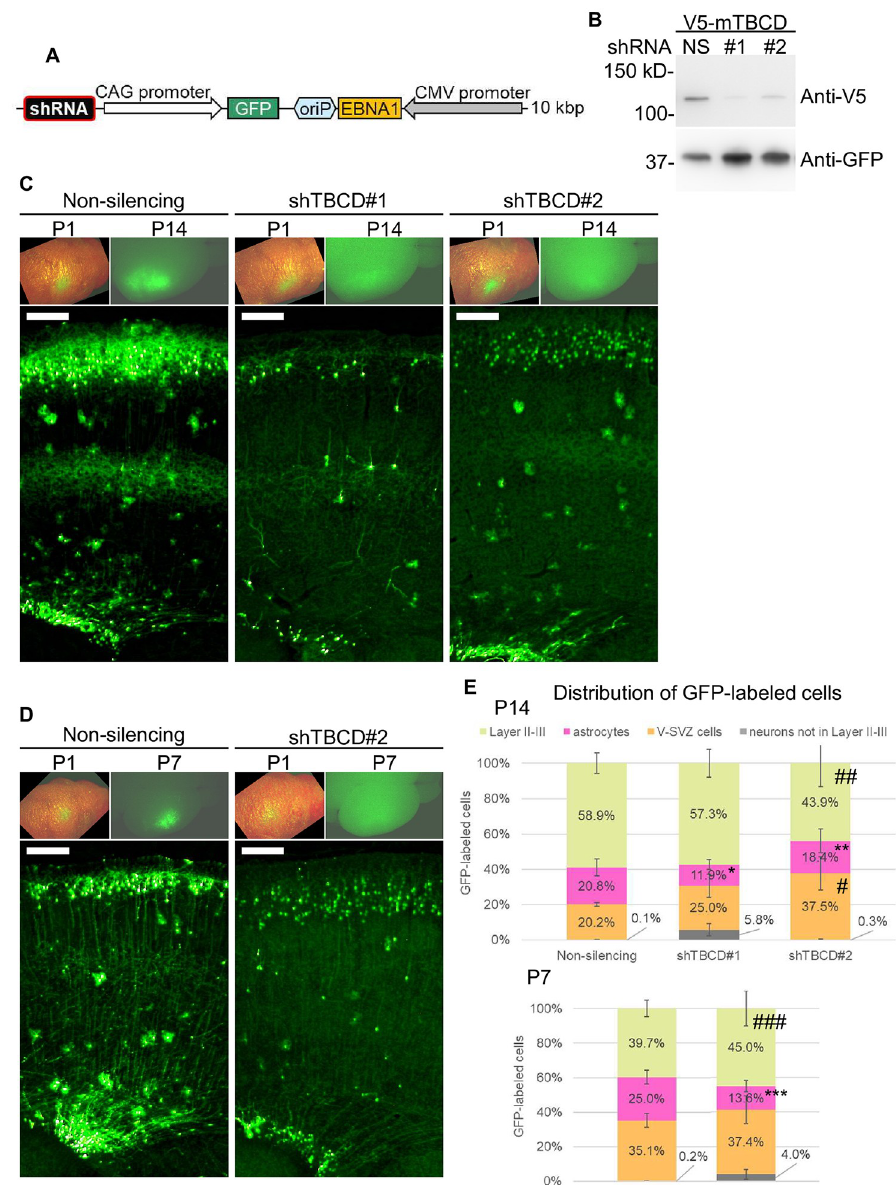
Fig 7. IUE of the EB-oriP plasmid encoding shRNA against TBCD suggests the role of TBCD in postnatal cerebral cortex. (A) Schematic illustration of the EB-oriP plasmid encoding shRNA expression in addition to GFP expression. The expression cassette of shRNA targeting mouse TBCD or non-silencing control was cloned into pCAG-GFP-EB-oriP plasmid (Fig 1A). IUE of these plasmids was performed at E15 and the brains were analyzed at P7 and P14. (B) Lysates prepared from HEK293T cells co-transfected with plasmids for V5-tagged mouse TBCD and plasmid shown in (A) (NS, non-silencing; #1 and #2, two independent shRNAs against TBCD) were analyzed by western blot with the indicated antibodies. (C and D) Representative GFP fluorescence of the head of a mouse transfected with the indicated plasmid at P1 was merged with the bright-field image (upper left). GFP fluorescence of the brain shown in left panel at P14 (C, upper right) and P7 (D, upper right). Representative GFP fluorescence of coronal section from the brain is shown in upper right panel. (E) Quantification of the distribution of GFP-labeled cells at P14 (upper) and P7 (lower) (P14: NS, n = 4085, from four mice; shTBCD#1, n = 926, from three mice; shTBCD#2, n = 1873, from four mice, P7: NS, n = 2768, from four mice; shTBCD#2, n = 1171, from three mice). Two to three sections from the central part of the transfected region per animal were counted. Data represent mean ± SEM. � P = 9.642e-09, �� P = 0.0003689, ��� P = 8.948e-15, #P = 1.22e-12, ##P = 0.0119, ###P = 0.003212, compared with NS (Fisher’s exact